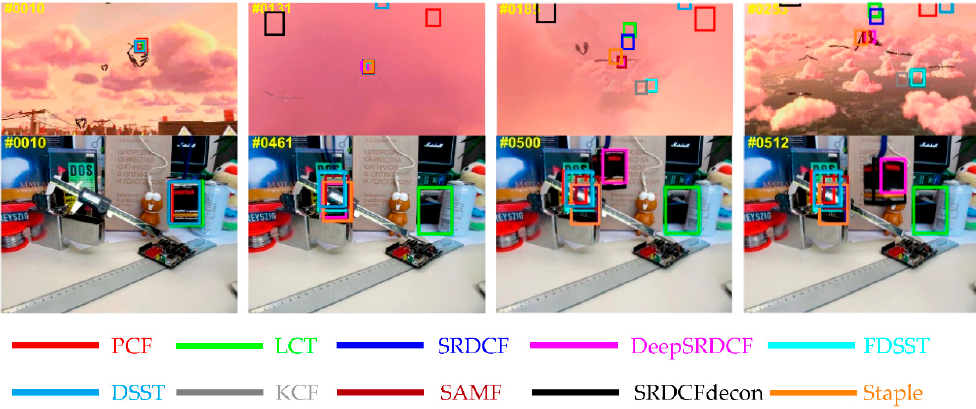
Figure 13. The failure cases from two representative sequences on the benchmarks. The tracking results for the top ten trackers are marked in different colors.